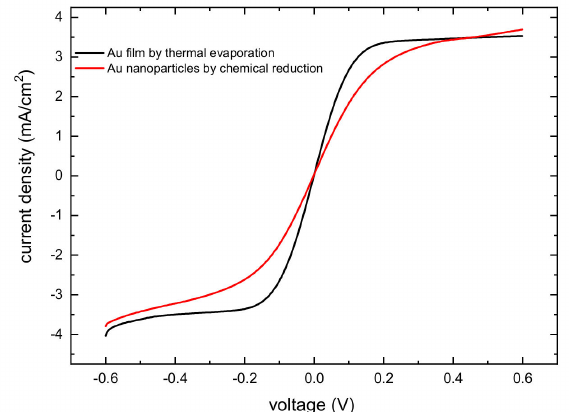
Figure 6. Linear scan voltammetry of 0.67 M Co(II)/(III) in a symmetric thin-layer cell (electrode spacing ca. 100 µ m) made with either Au nanoparticles or evaporated gold